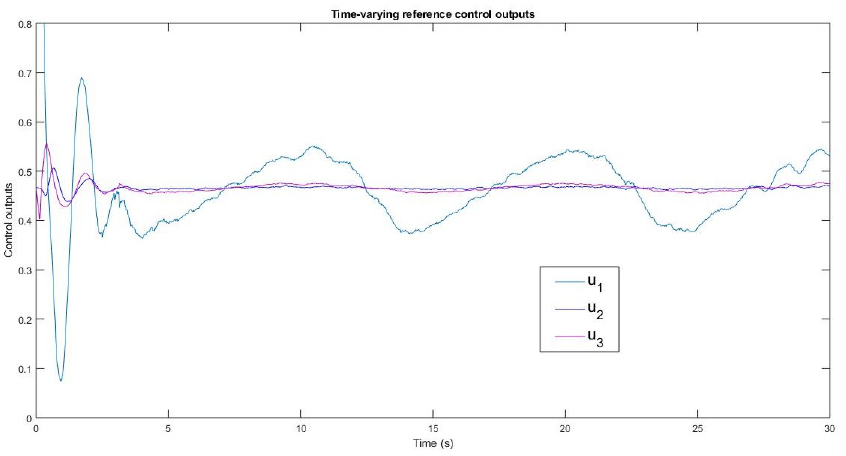
Figure 8. Experimental control outputs for each agent following a sinusoidal reference.